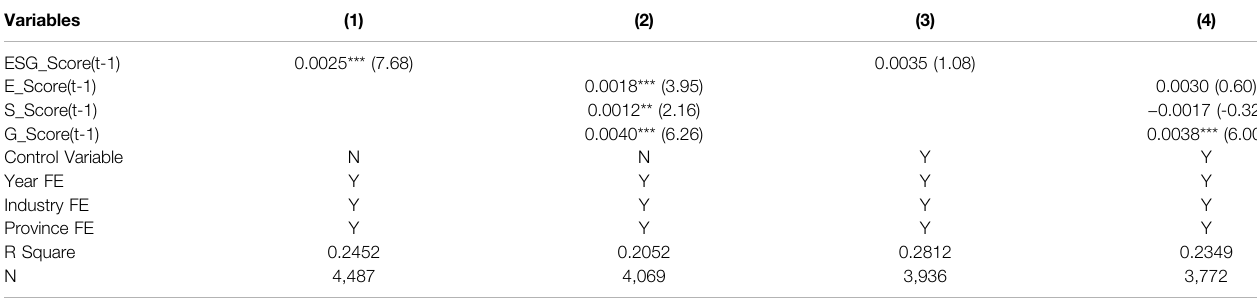
TABLE 3 | Results of OLS regression (dependent variable: equity ownership held by SWFs). Variables